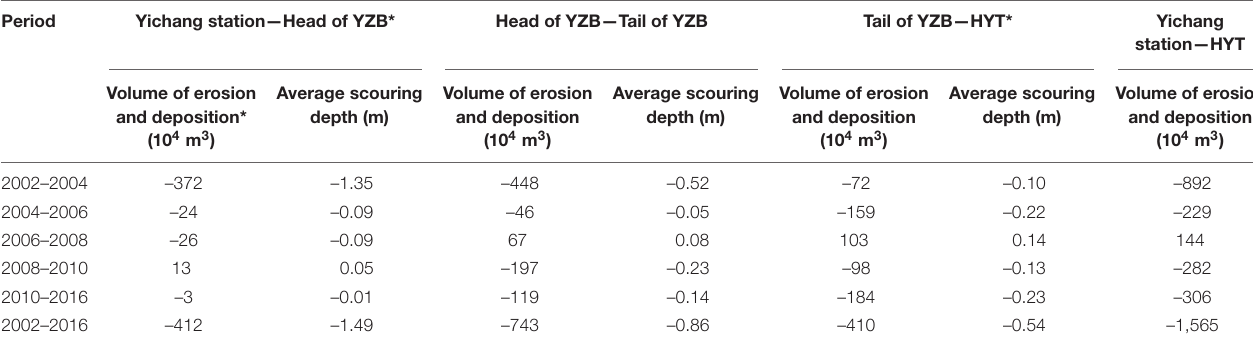
TABLE 1 | Statistics of the erosion and deposition volume in the Yichang reach at the water level of 43.3 m in different periods.